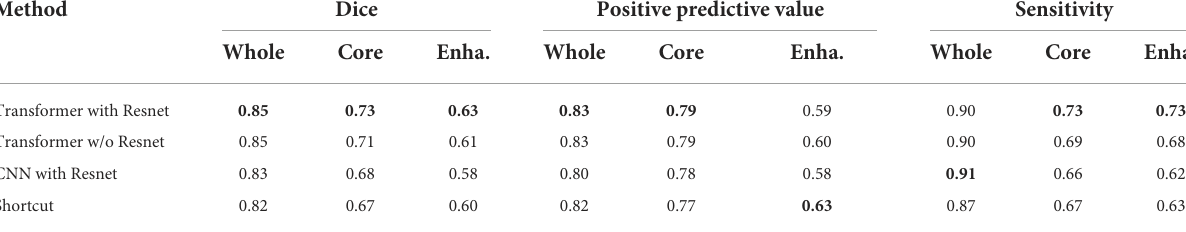
TABLE 3 Results of different bottom layer in generator.